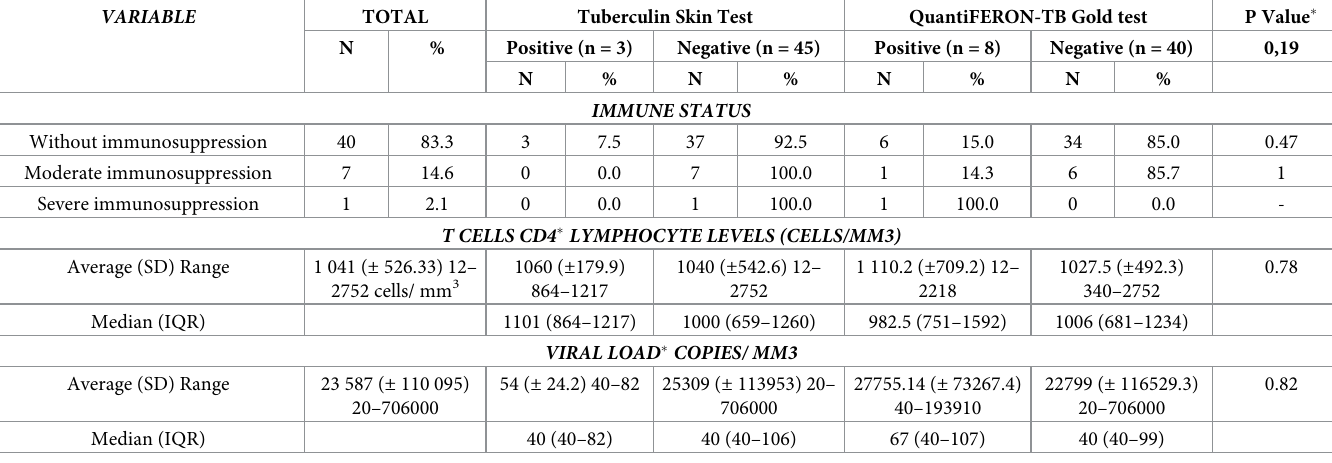
� comparison test of measures between positive cases according to the test used for the total and